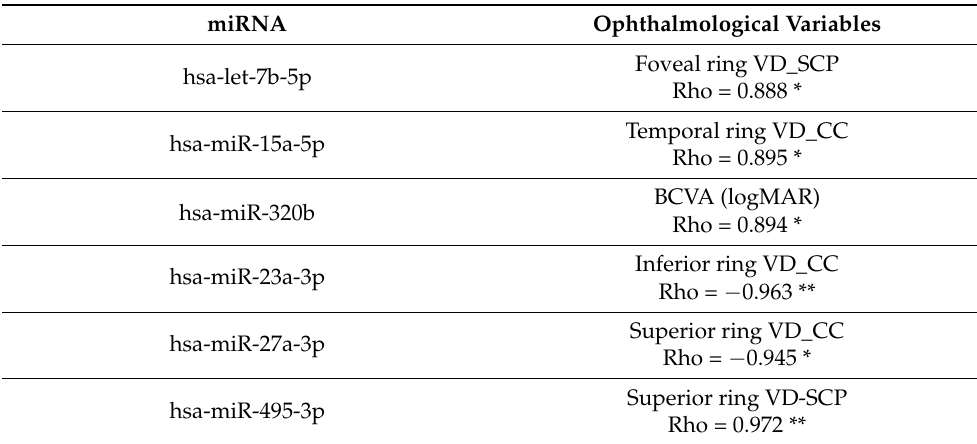
Nonparametric correlation coefficients between circulating miRNAs and anatomical/functional and perfusion variables in patients with diabetes. miRNA